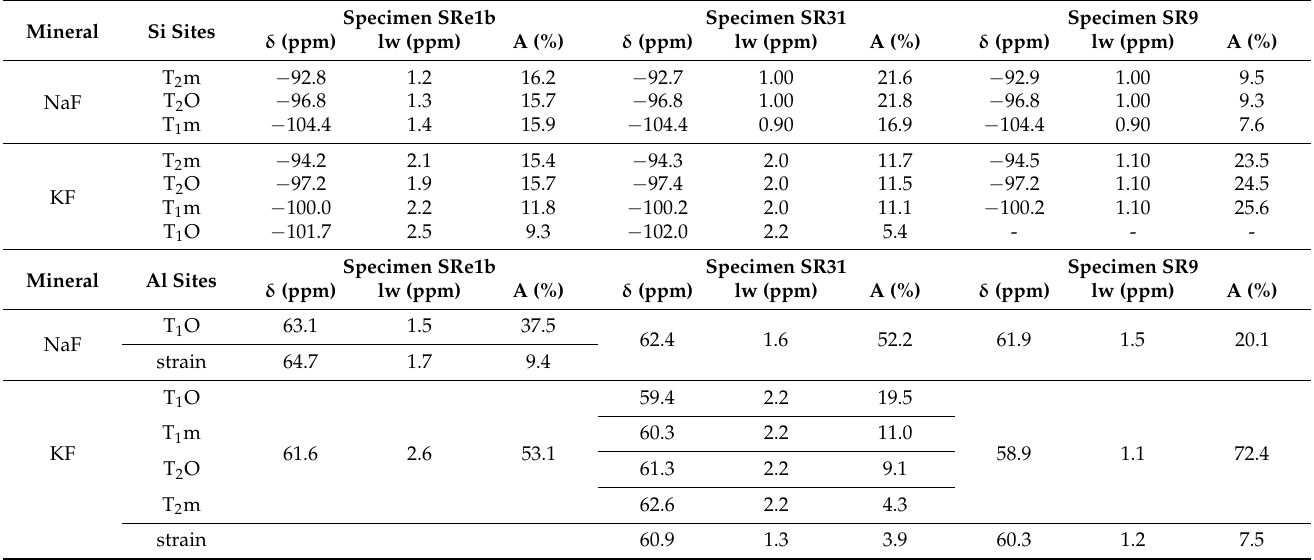
Table 9. Data of the simulations of the 29 Si NMR spectra at 9.4 T and of the 27 Al NMR spectra at 35.2 T, in specimens SRe1b, SR31 and SR9 (Figure